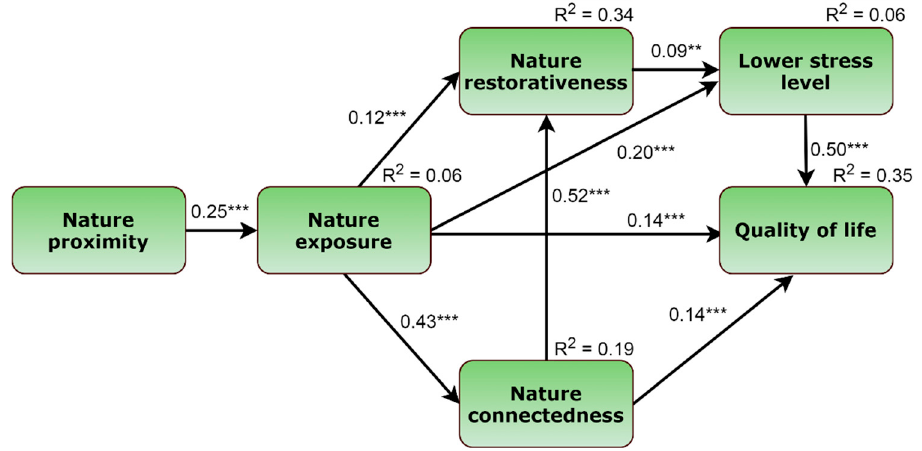
Figure 2. The final path model (CFI = 0.981; RMSEA = 0.061; 90% CI = 0.038–0.085). ** p < 0.01; *** p < 0.001. Table 4. Indirect effects with standard error (SE) and 95% confidence intervals in the final path model. Pathway